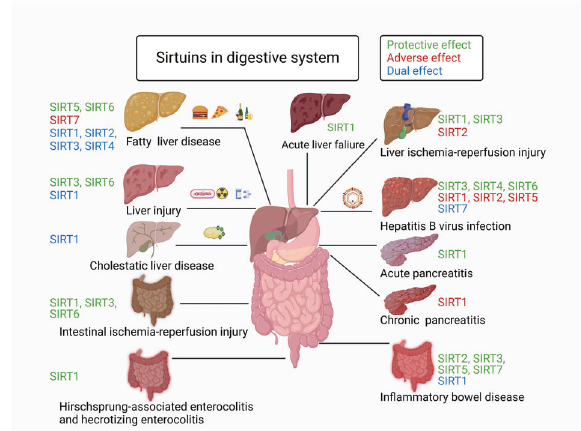
Fig. 12 The roles of SIRTs in digestive system, mainly including FLDs, liver and intestinal ischemia-reperfusion injury, HBV infection, pancreas diseases, and IBDs. In FLDs, SIRT1, SIRT2, SIRT3, and SIRT4 could provide protective effects, while the role of SIRT7 may